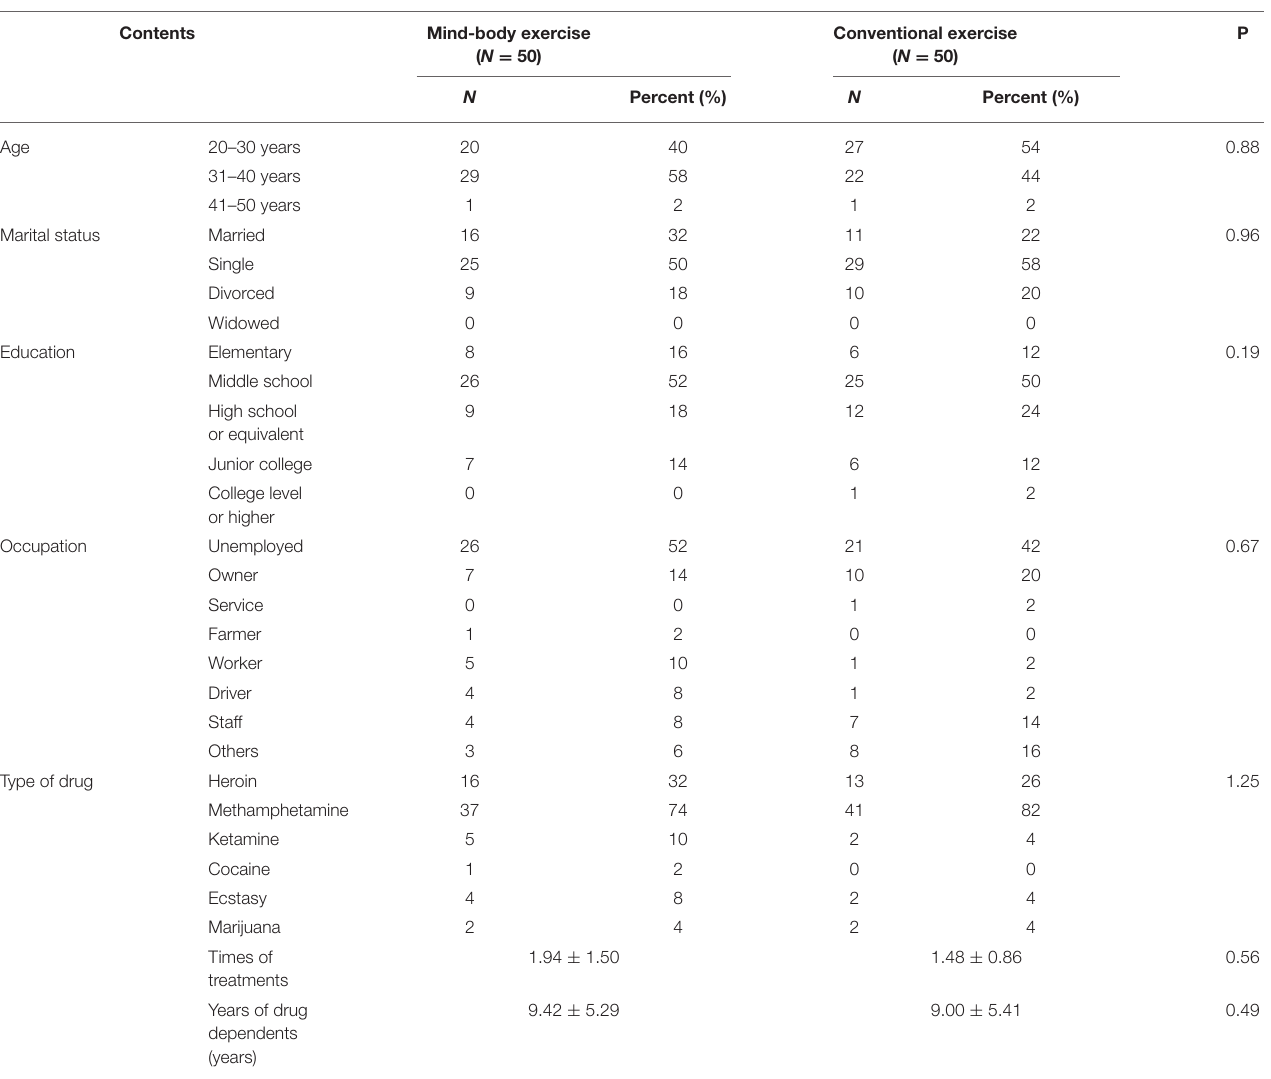
TABLE 1 | Demography of individuals with substance use disorder ( N =